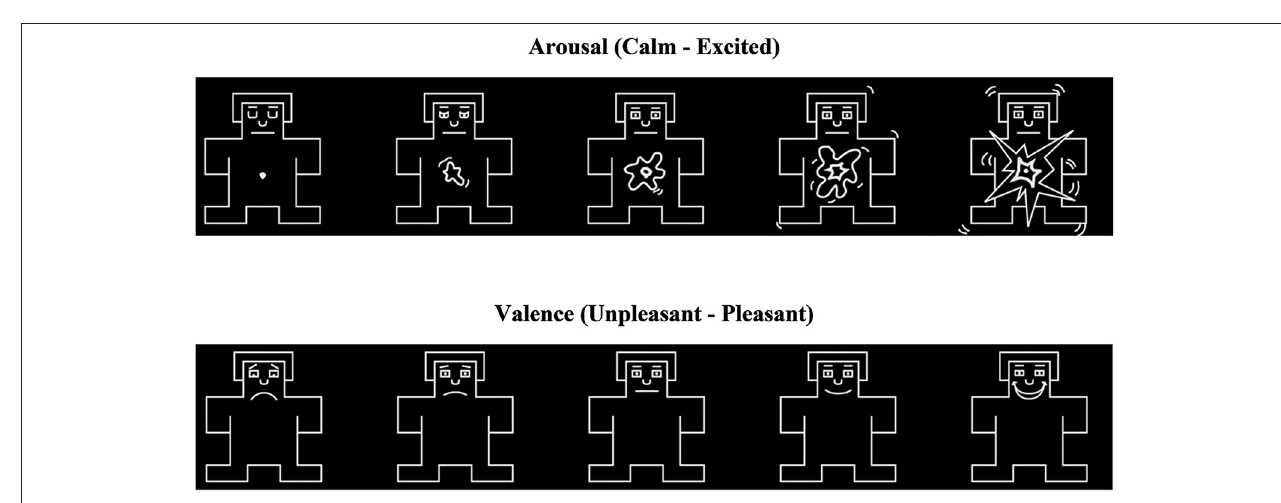
FIGURE 3 | SAM figures to measure valence and arousal